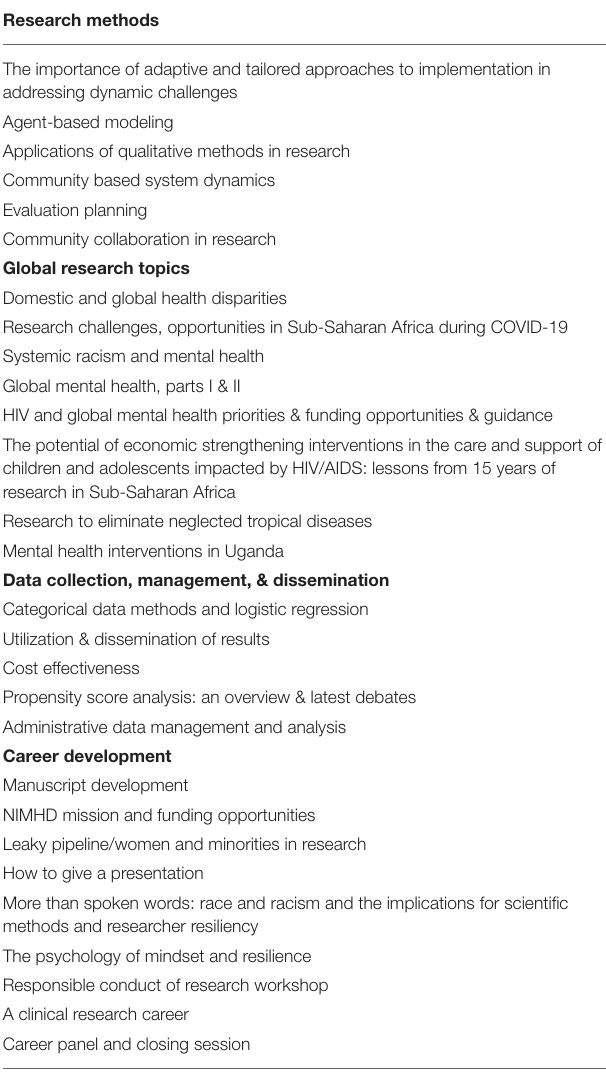
TABLE 1 | First year intensive summer training curriculum by